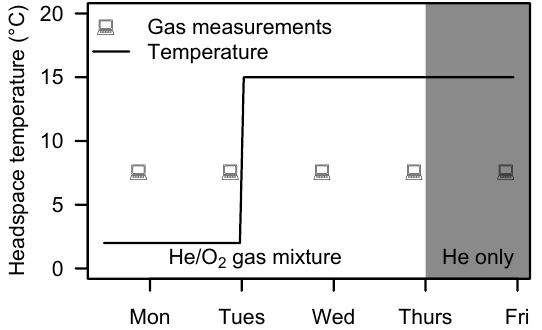
Figure 1. Course of incubation and gas measurements with respect to atmosphere and temperature of the headspace after 2 days of pre- incubation at 2 ◦ C in the He / O 2 gas mixture. Gas concentrations of the headspace were determined on 5 consecutive days, i.e. Monday to Friday in the morning. After the first 2 measurement days, the headspace temperature was increased from 2 to 15 ◦ C. Addition- ally, after the fourth measurement day, the aerobic helium / oxygen gas mixture in the headspace was replaced by a pure helium atmo-